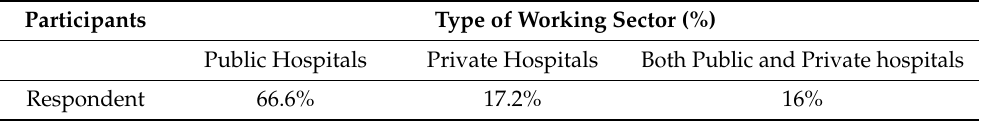
Table 2. Participants’ working sector information.